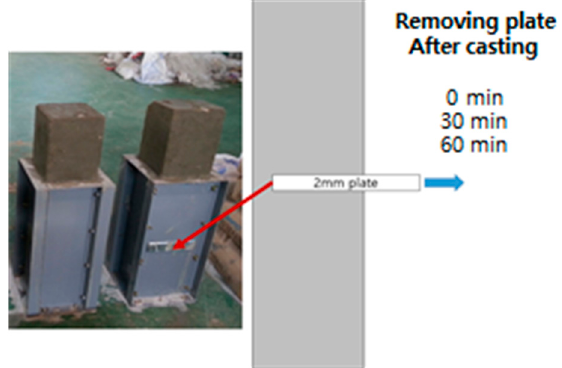
Figure 3. Formations of interface at different times.